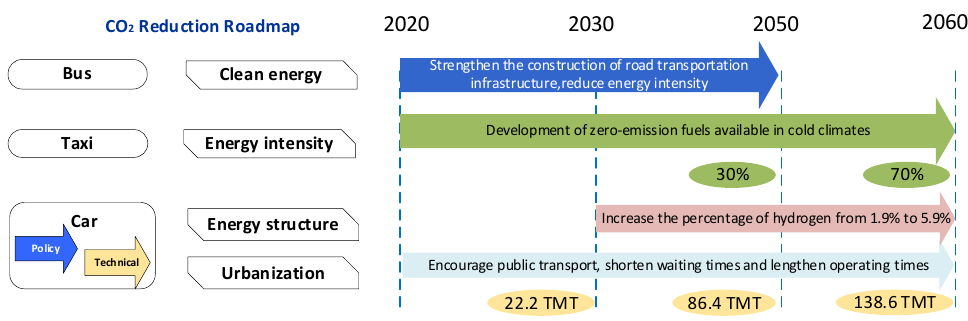
Figure 6. CO 2 reduction roadmap for the urban transportation sector in ELS.